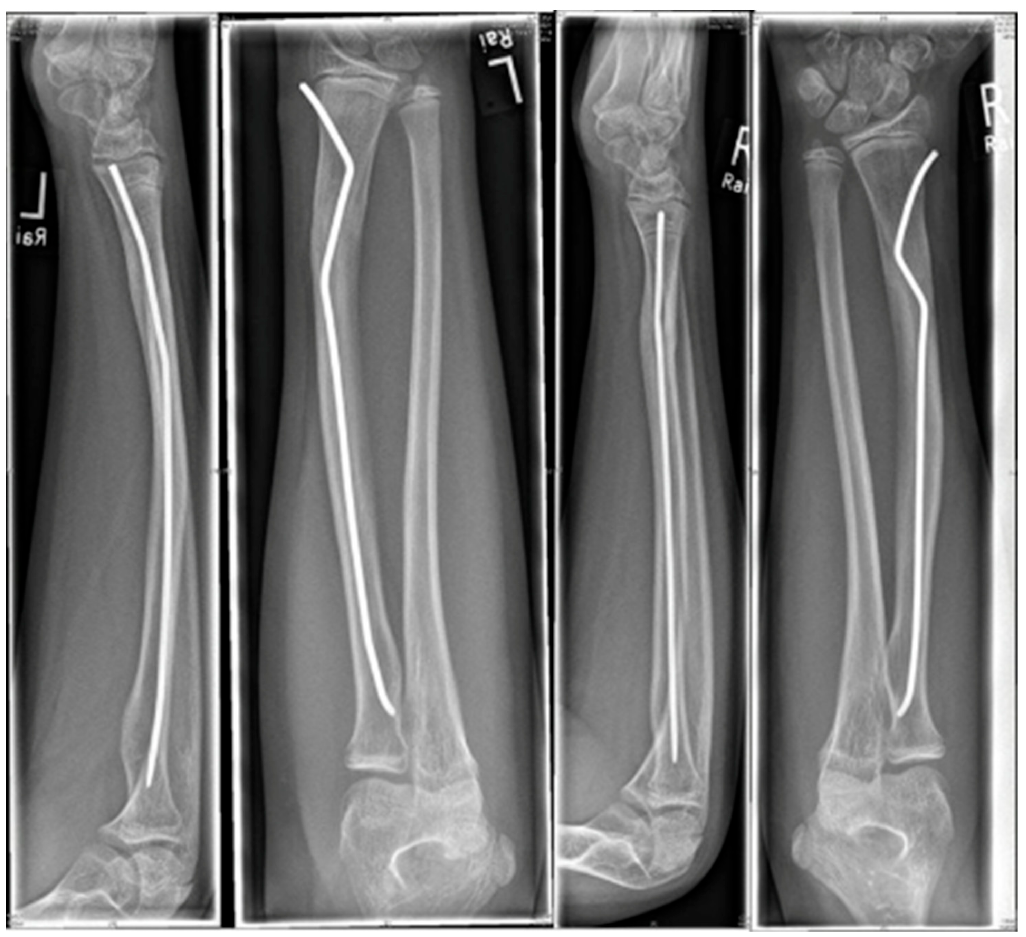
Scheme 4. Open forearm fracture leaving the fracture of the ulna to spontaneous correction.